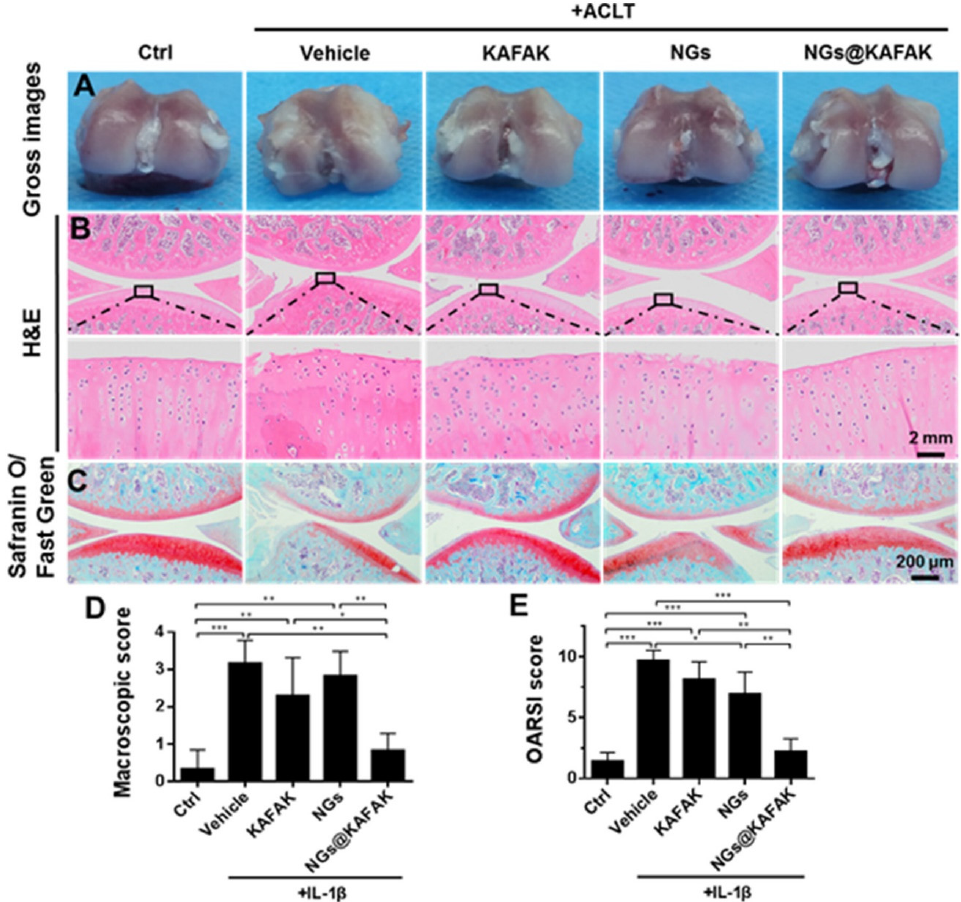
Figure 6. Intra-articular injection of NGs slows down cartilage degeneration in anterior cruciate ligament transection osteoarthritis (ACLT) induced rat osteoarthritis model. ( A ) Macroscopic appear- ance of cartilage from tibial plateaus, ( B ) H&E staining of knee joints, ( C ) Safranin O/Fast Green stained sections of knee joints, ( D ) The macroscopic observation scores of knee joints, ( E ) Carti- lage degeneration evaluated with the Osteoarthritis Research Society International (OARSI) scoring system. (* p < 0.05, ** p < 0.01 and *** p < 0.001). Reproduced from Li et al. [180] with permission from